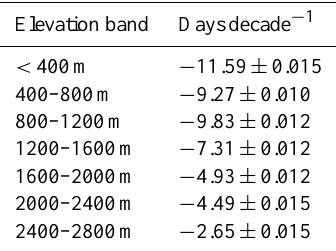
Table 1. Melt onset trend in daysdecade − 1 for different elevation bands derived from passive microwave data using the approach by Mote and Anderson